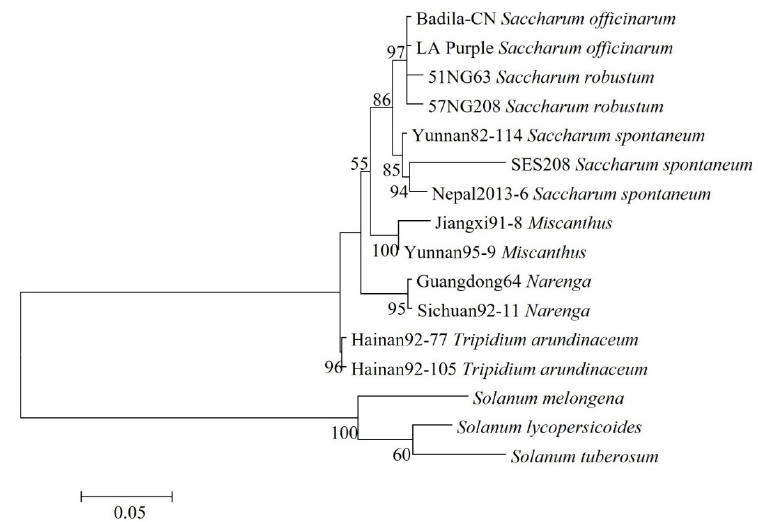
Figure 3. Phylogenetic tree of rDNA-ITS sequence that include three taxa of the Solanum genus as an outgroup, and six taxa from the Saccharum complex, including genera Saccharum , Tripidium , Miscanthus , and Narenga were used for phylogenetic analyses. Bootstrap values over 50% after 1000 replications are indicated at the nodes.